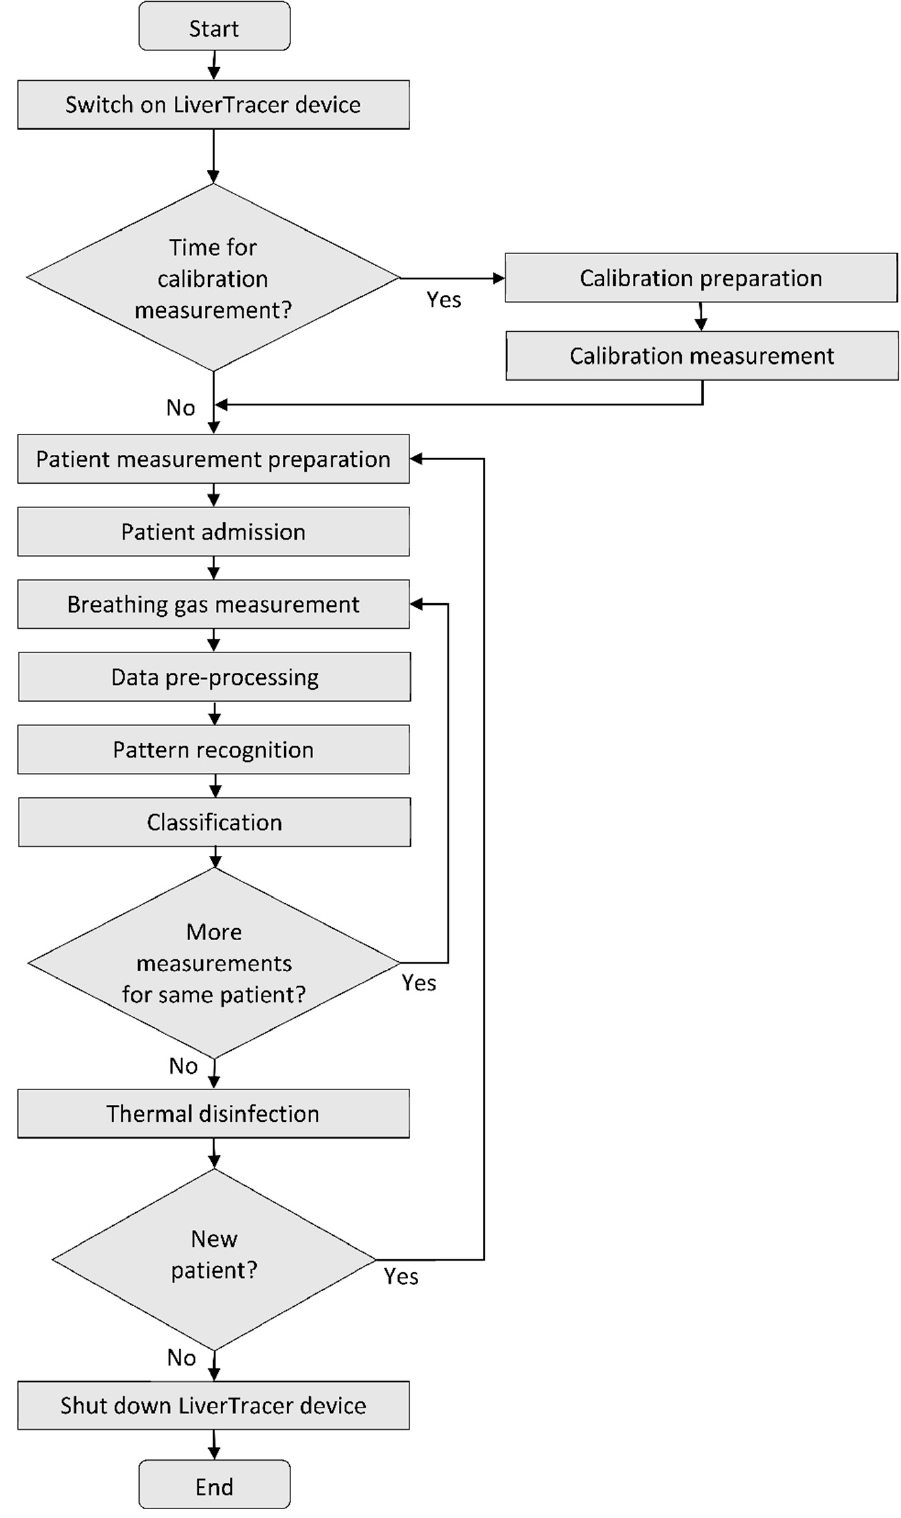
Figure 2. Flow chart of the LiverTracer measurement regime.